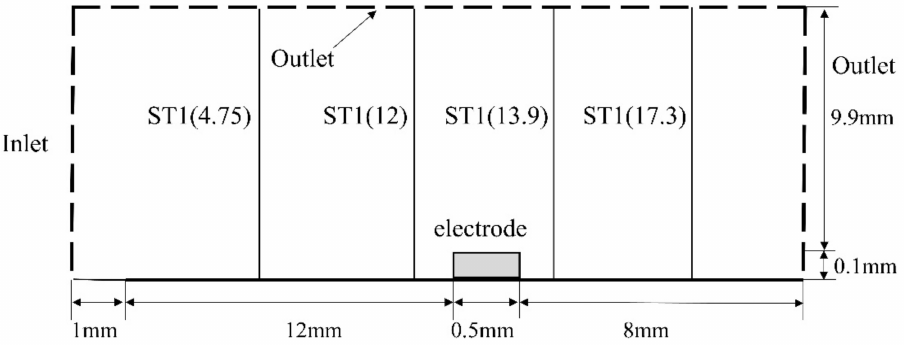
Figure 2. Schematic diagram of calculation domain.